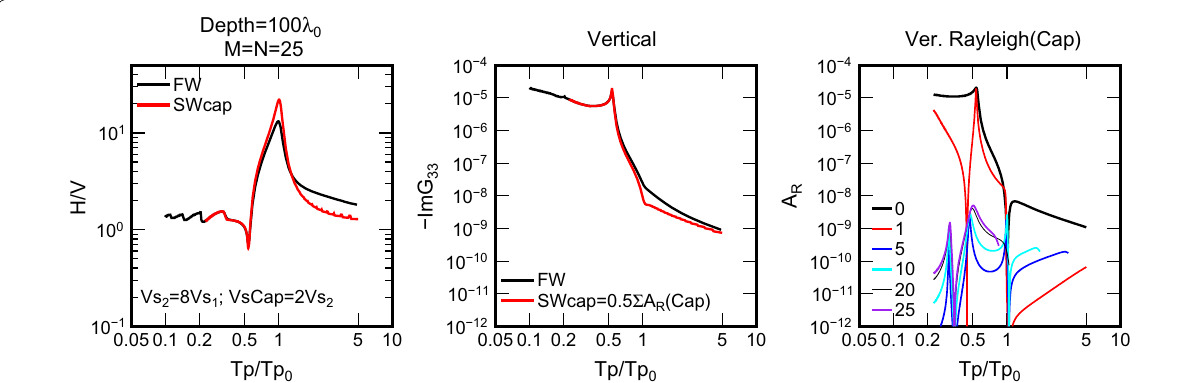
Fig. 5 H / V s, imaginary parts of the Green’s function in the vertical component and vertical medium responses of Rayleigh waves from fundamental mode to 25th higher mode. The depth of upper interface of cap layer is 100 λ 0 . Left: FW H / V (thick black) for target two‑layered medium ( V s2 8 V s1 ), = and SW H / V (red) for cap‑layered medium ( V sCap 2 V s2 , Depth 100 λ 0 ). Middle: imaginary parts of the Green’s function of FW (thick black) in the = = vertical component for target two‑layered medium and that of SW (red) for cap‑layered medium. Right: vertical medium responses of Rayleigh waves for fundamental mode (black), first higher mode (red), fifth higher mode (blue), 10th higher mode (cyan), 20th higher mode (thin black), and 25th higher mode (purple). For clarity, medium responses are depicted for only six modes. The medium responses below 0.2Tp 0 are omitted because the calculation becomes rather difficult when the dispersion curves of higher modes are quite close to one another at very short periods